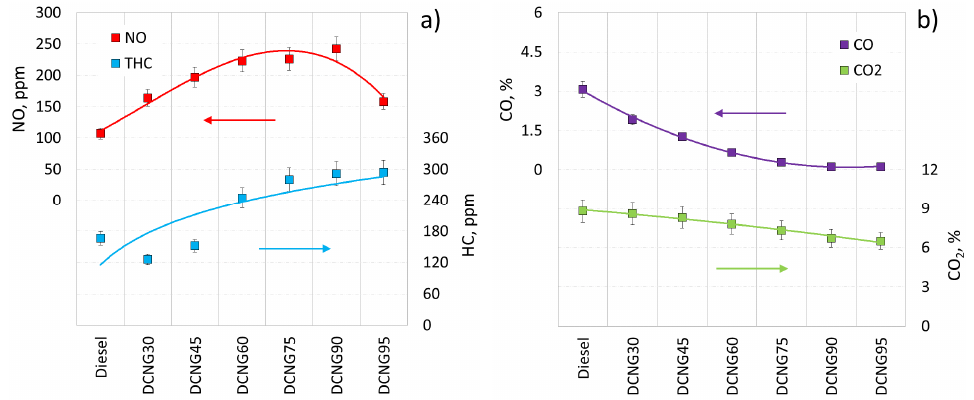
Figure 6. Emissions of NO and hydrocarbons (HC) ( a ), and CO and CO 2 ( b ) for the dual fuel engine